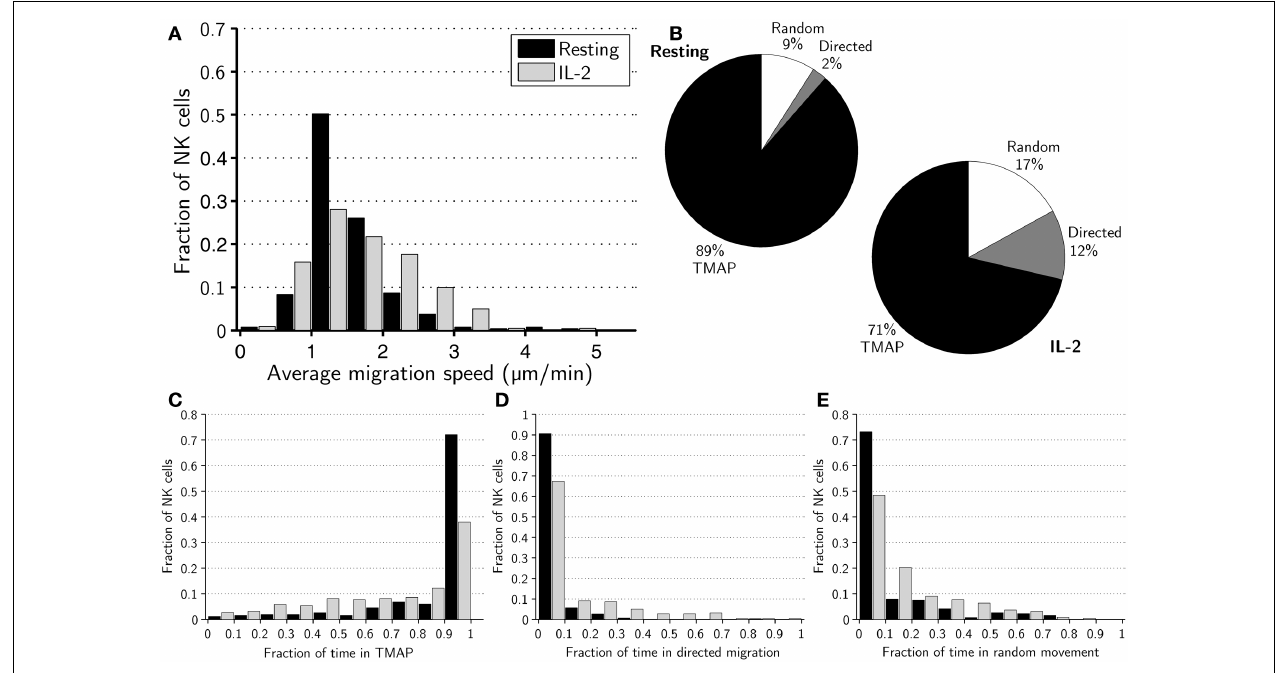
FIGURE 1 | Migration dynamics of resting and activated NK cells . (A) Distributions of average migration speeds for resting (black bars) and activated (gray bars) NK cells. (B) Pie charts showing mean fraction of time spent inTMAPs (black), directed migration (gray), and random movement (white) for resting (left chart) and activated (right chart) NK cells.